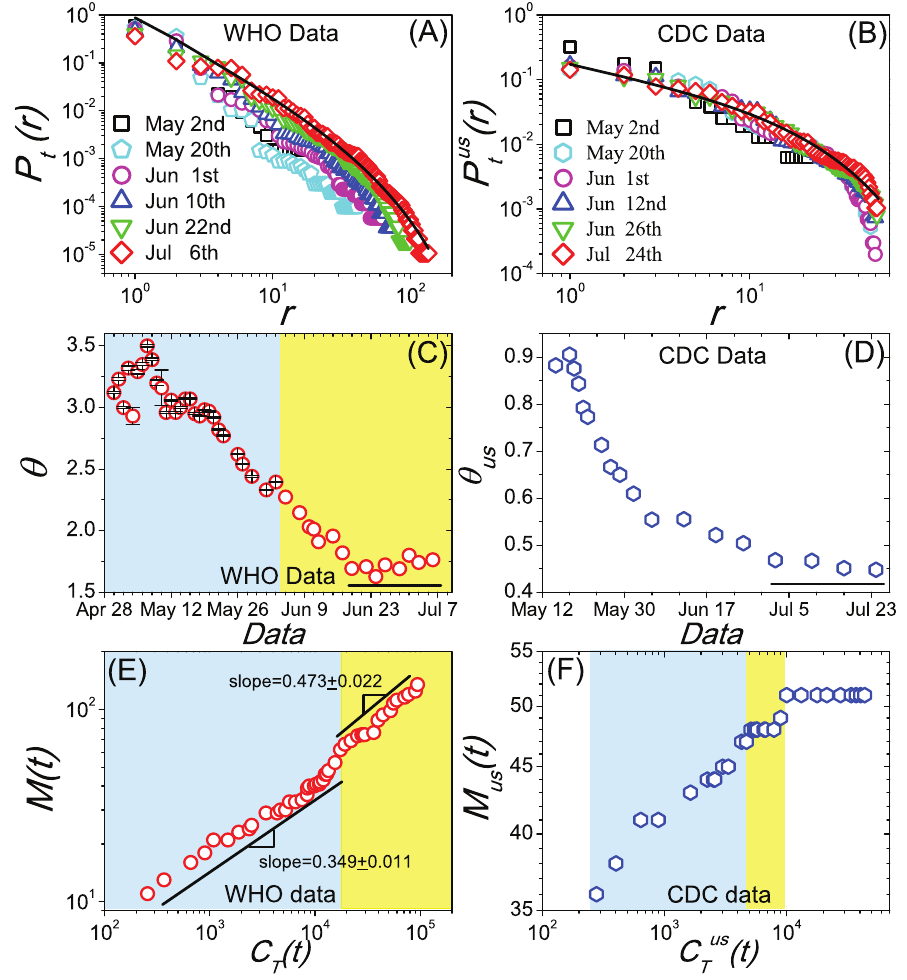
Figure 1. The empirical results of A(H1N1). (A) The Zipf-plots of the normalized probability-rank distributions P t ( r ) of the cumulated confirmed number of every infected country at several given date sampled about every two weeks, data provided by the WHO. (B) The Zipf-plots of P us several given data sampled about every two weeks, data provided by the CDC. (C) Temporal evolution of the estimated exponent h of the normalized distribution P t ( r ) . (D) Temporal evolution of the estimated exponent h us of the normalized distribution P us sublinear relation between the number of infected countries M ( t ) and the cumulative number of global confirmed cases C T ( t ) , data collected by the WHO. (F) The sublinear relation between the number of infected states M us ( t ) and the cumulative number of national confirmed cases C us collected by the CDC. The shaded areas in the figures (C,E,F) corresponds to their different evolution stages,